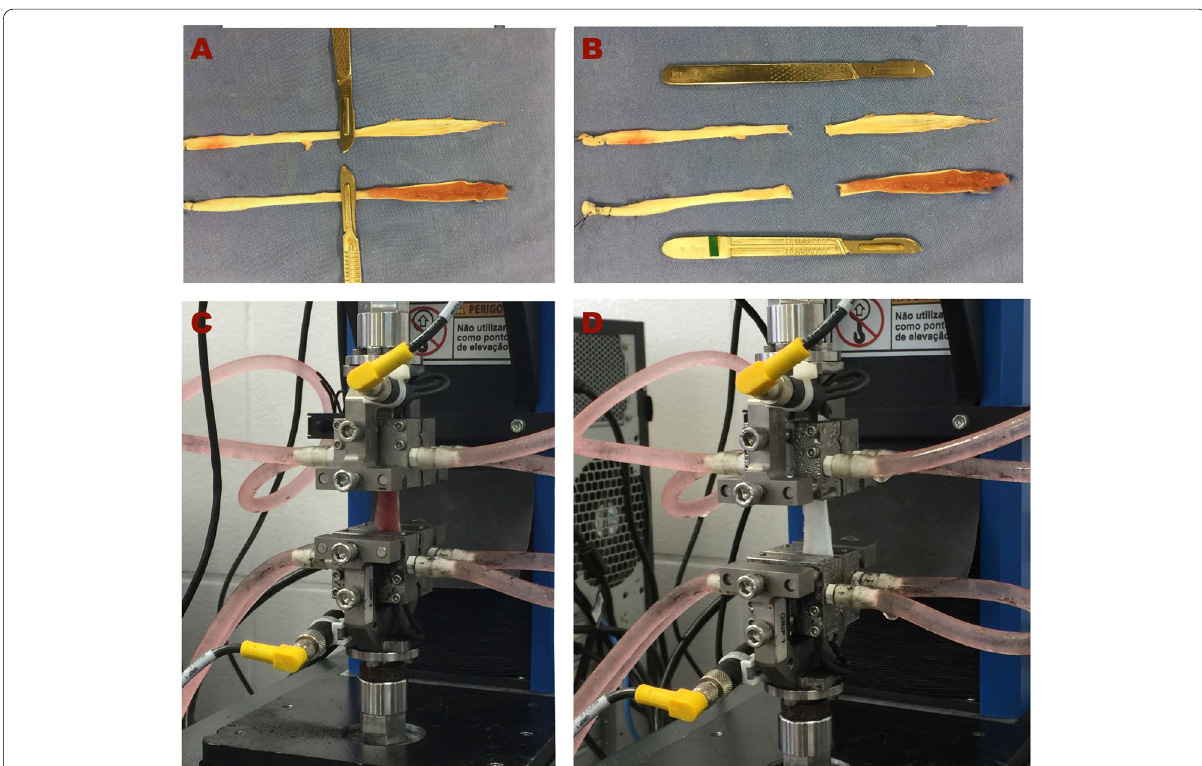
Fig. 4 After harvesting the porcine flexor digitorum superficialis muscle tendon ( A ), the musculotendinous tissue was cut for comparison of both tendon tissues under the same conditions ( B ). Each pair of tendons was tested in an Instron TestMaster Automation System: the tendon with muscle ( C ) and the tendon without muscle ( D ). The distance between the tendon fixation points was 30 mm. The cryoclamp (pink liquid inside the hoses) was used to reduce the risk of slippage of the tested